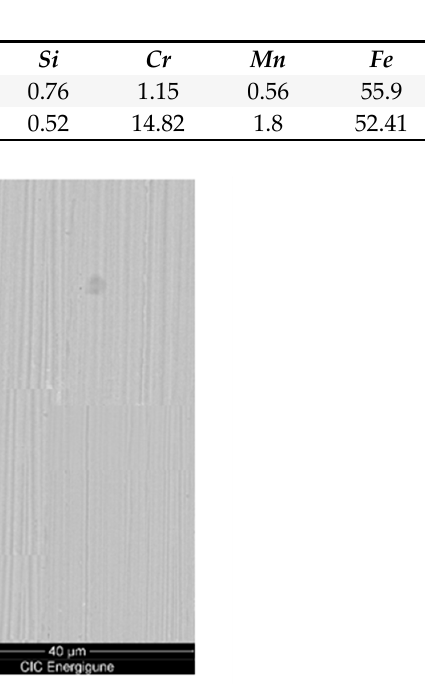
Figure 11. Cross-section image of OC4 alloy after 500 h in KOH at 380 °C, including EDX analysis at A-B point.